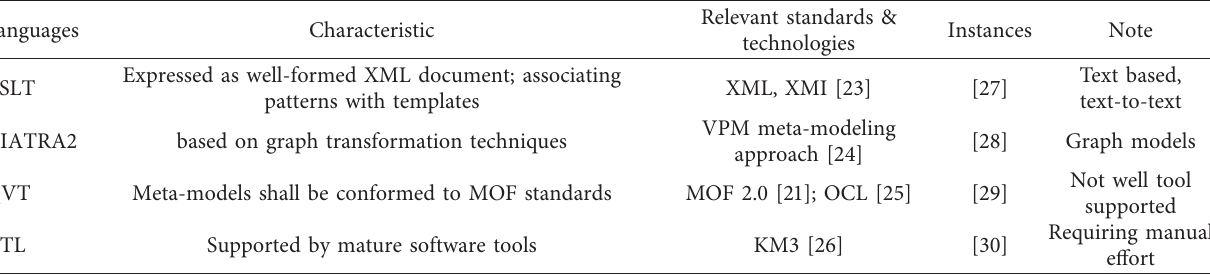
Table 1: Model transformation languages and